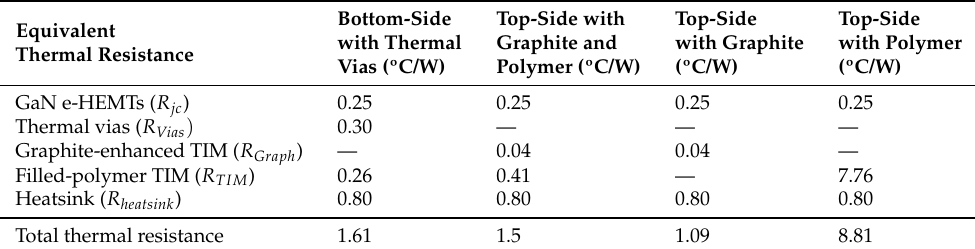
to 25 ºC. Table 3 details the thermal resistances included in the model. Each half-bridge had its heatsink, so the equivalent thermal resistances in a half-bridge are detailed. Table 3. Thermal resistances included in the simulation